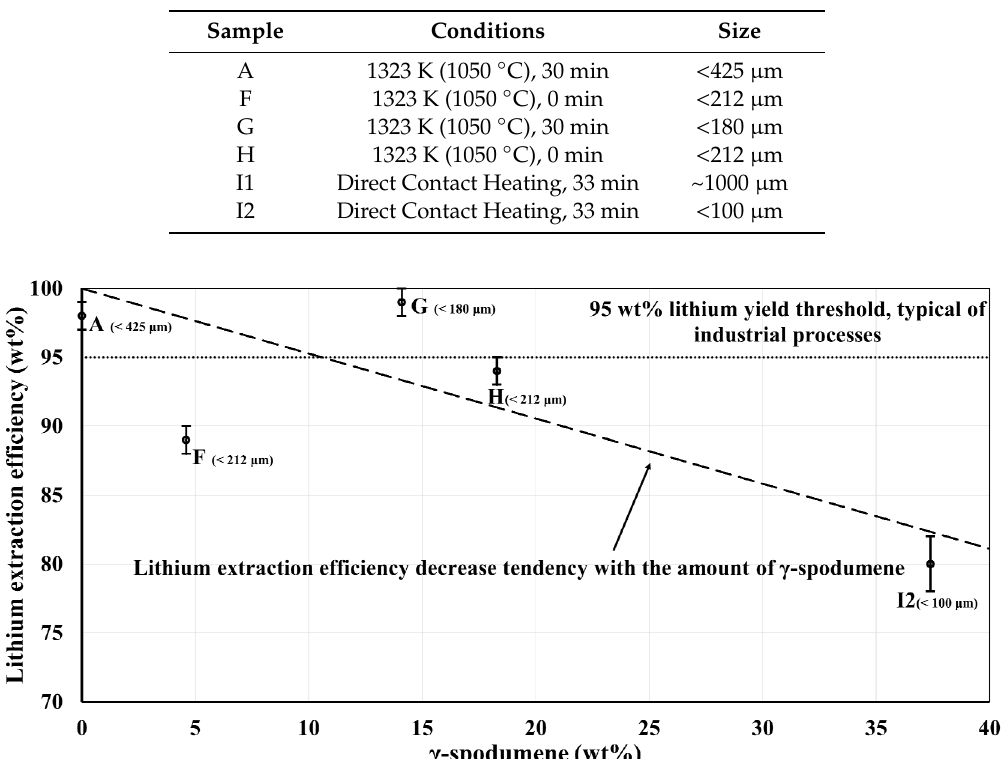
Figure 6. Influence of the amount of γ -spodumene on lithium extraction efficiency by acid leaching for various heat-treated concentrates. Furnace heat treatment: samples A, F, G, and H. Direct contact heating treatment with size normalization grinding: sample I2.